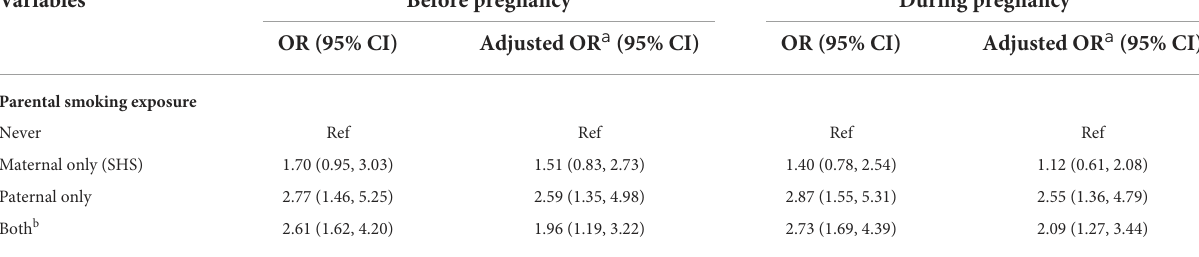
TABLE 2 The associations of parental smoking exposure before/during pregnancy and offspring ADHD risk. Variables